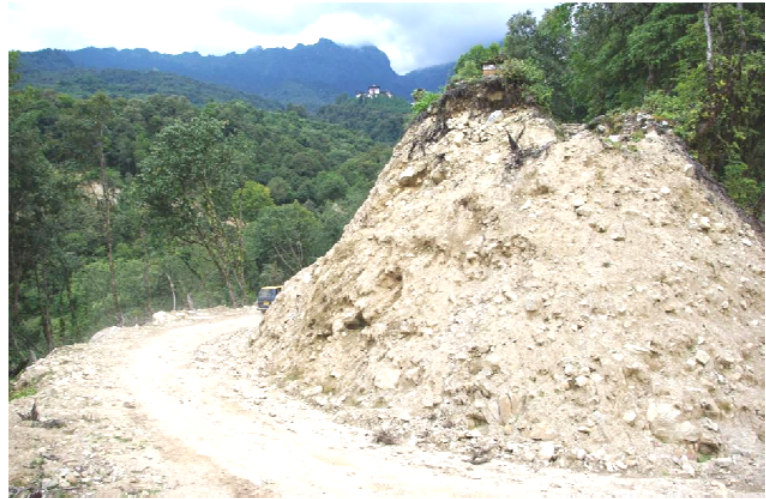
Figure 13. Trail with Cholten cut off by new road near